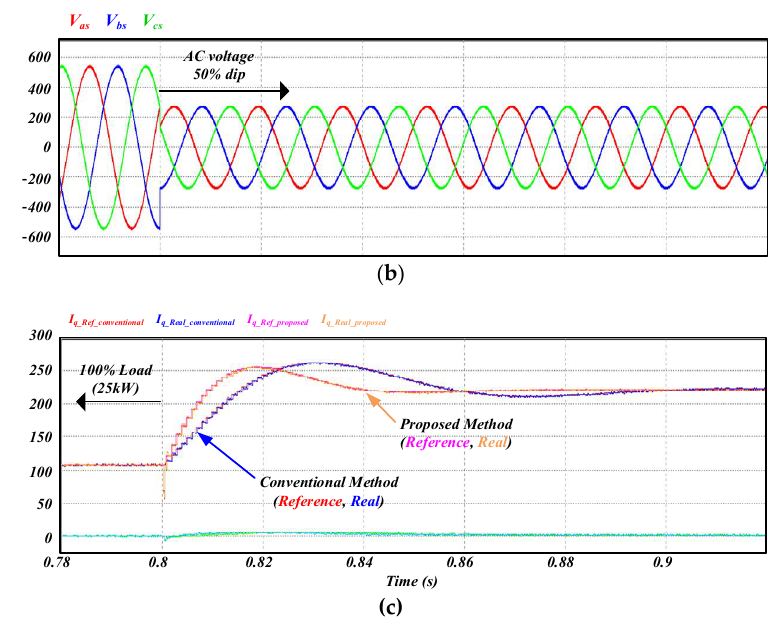
Figure 11. Dynamic response of DC grid voltage to AC voltage dip. ( a ) Comparison of DC voltage dynamic responses at voltage dip occurrence; ( b ) occurrence of AC voltage dip by 50%; and ( c ) comparison q -axis current control characteristic.